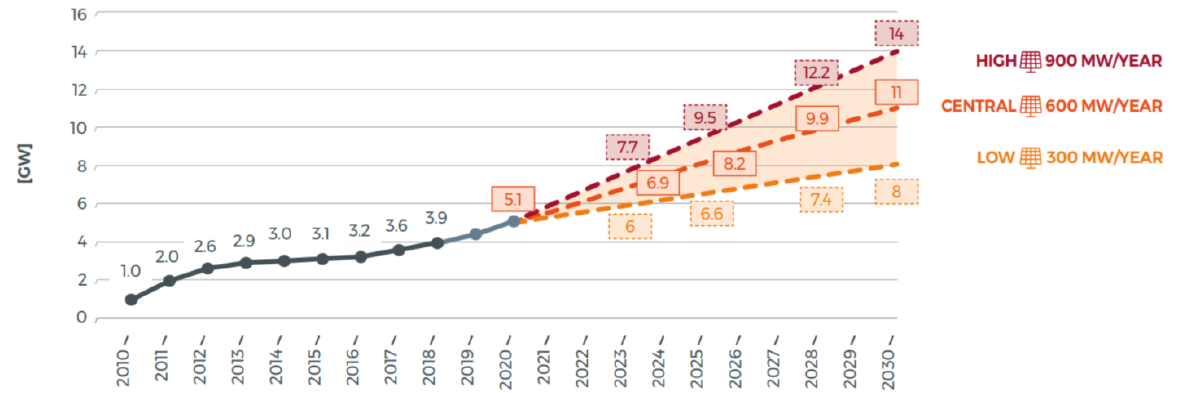
Figure 24. Historical and predicted values of offshore wind installed capacity in Belgium [153].